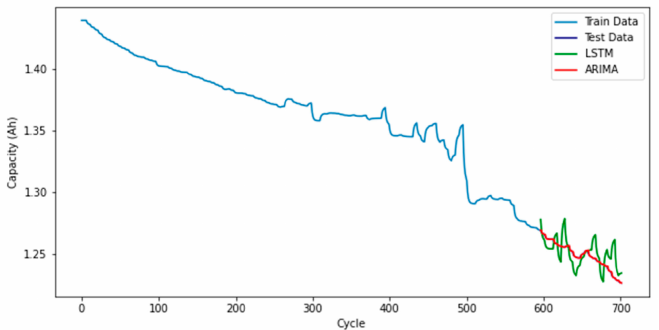
Figure 12. Train, test, and predicted data results from ARIMA and LSTM models for PL11.